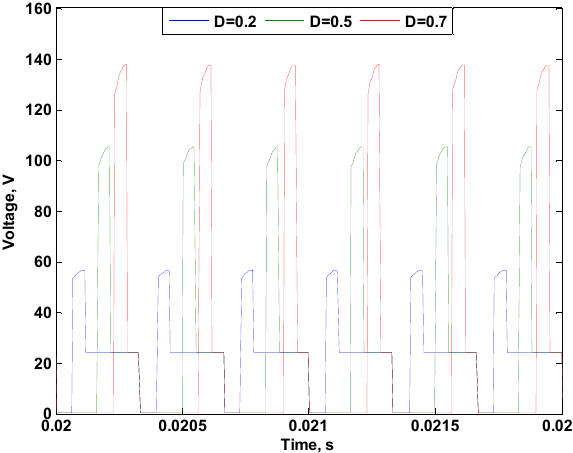
Figure 10. Voltage stress across the first-stage switch.